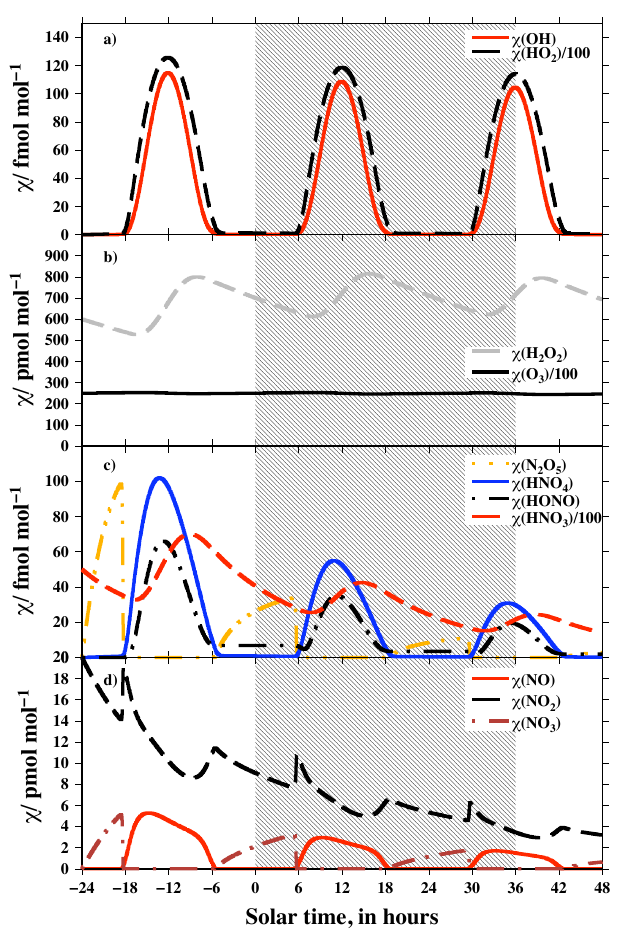
Fig. 3. Time series of the mixing ratio ( χ ) of the main atmo- spheric species studied, for the base model run ( T = 293K, 45 ◦ N, see Sect. 3.4 for details). (a) OH and HO 2 , (b) O 3 and H 2 O 2 , (c) N 2 O 5 , HNO 4 , HNO 3 and HONO, (d) NO, NO 2 and NO 3 . The shaded area represents the time period used in the rest of article for the isotopic